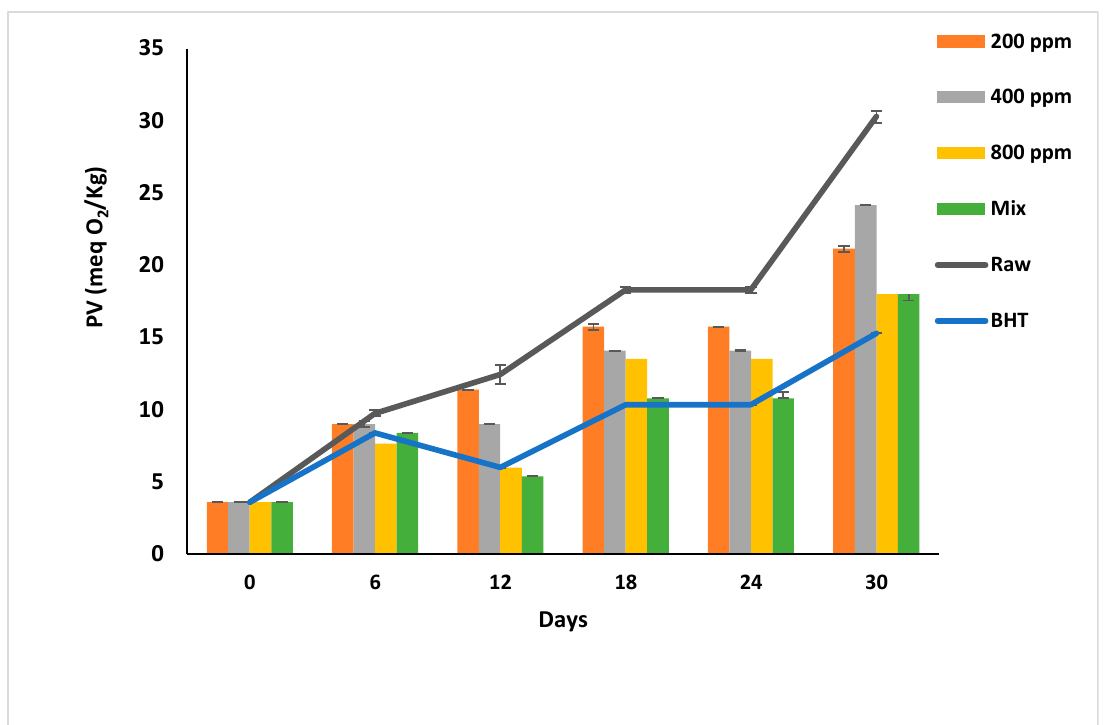
Figure 2. Peroxide value (meq O 2 /Kg) of raw soybean oil (without antioxidants) and soybean oil enriched with PGG leaves extract (200, 400, and 800 ppm), BHT (200 ppm), and a PGG/BHT mixture (400/100 ppm) during the accelerated storage days (30 days) at 65 °C.